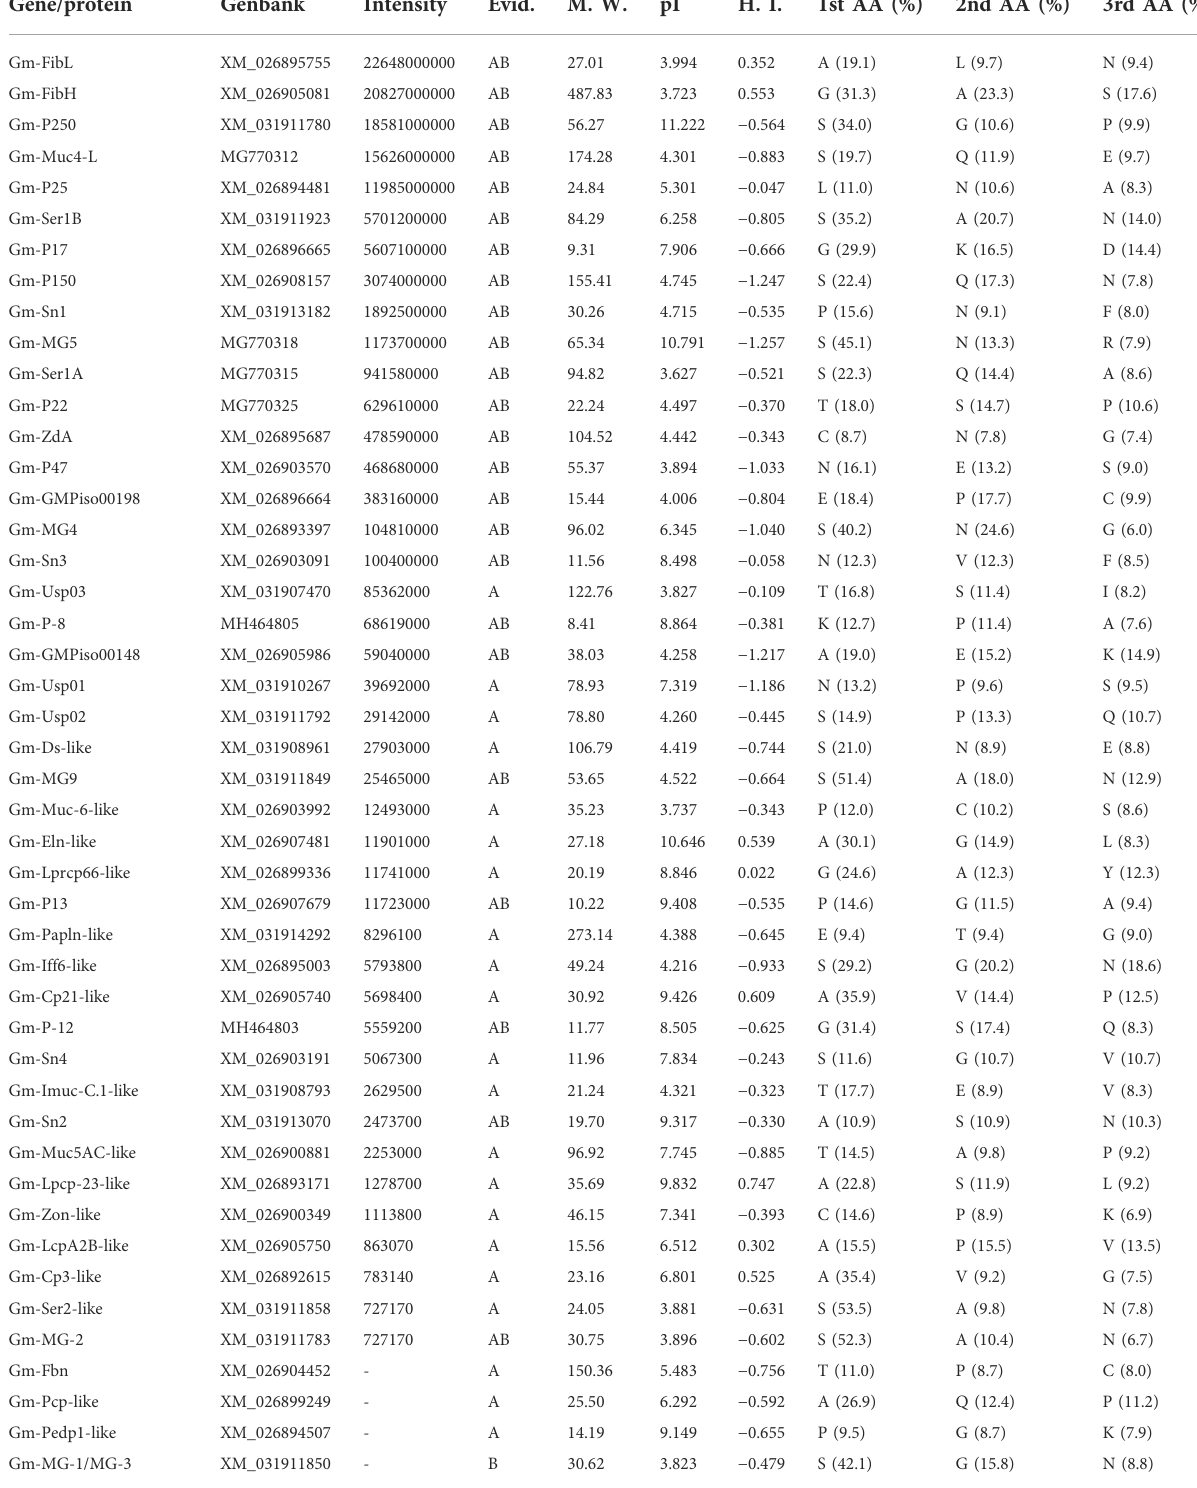
TABLE 2Majorsilk proteinsin G.mellonella cocoon.GenBankaccessionnumbers;Intensity – MaxQuantpeptideintensity;M.W. – molecular weight (kDa); pI – isoelectric point; H. I. – hydrophobicity index (GRAVY); 1 st /2 nd /3 rd AA (%) – proportion of the three most frequent amino